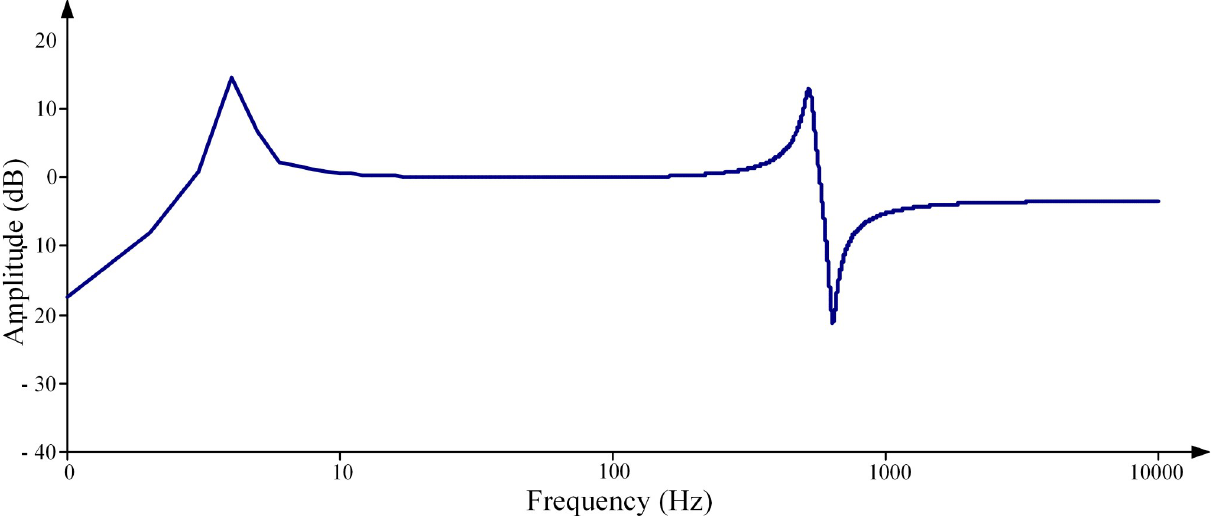
Fig 14. Amplitude-frequency characteristic of the transformation ratio of the 35-kV CVT.